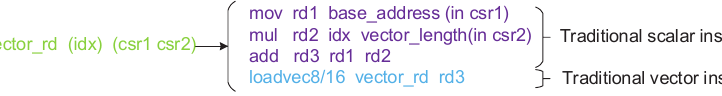
Figure 8. The basic vector load/store instructions equivalent.